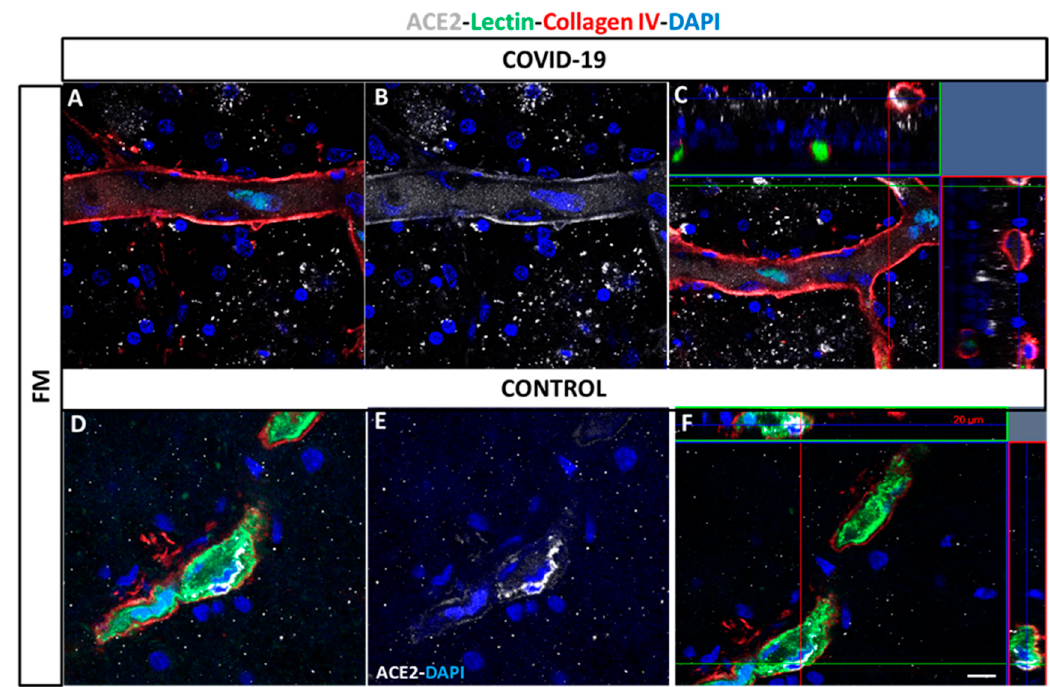
Figure 4. Localization of ACE2 in vessels in post-mortem flat-mounted COVID-19 ( A – C ) and control retinas ( D – F ). Samples label with lectin (green), collagen IV (red) and ACE2 white). ACE2 expression is analyzed in superficial and deep vasculature. ACE2: Angiotensin-converting enzyme 2, FM: flat-mounted. DAPI (blue) label nuclei. Scale bar: 200 µm.